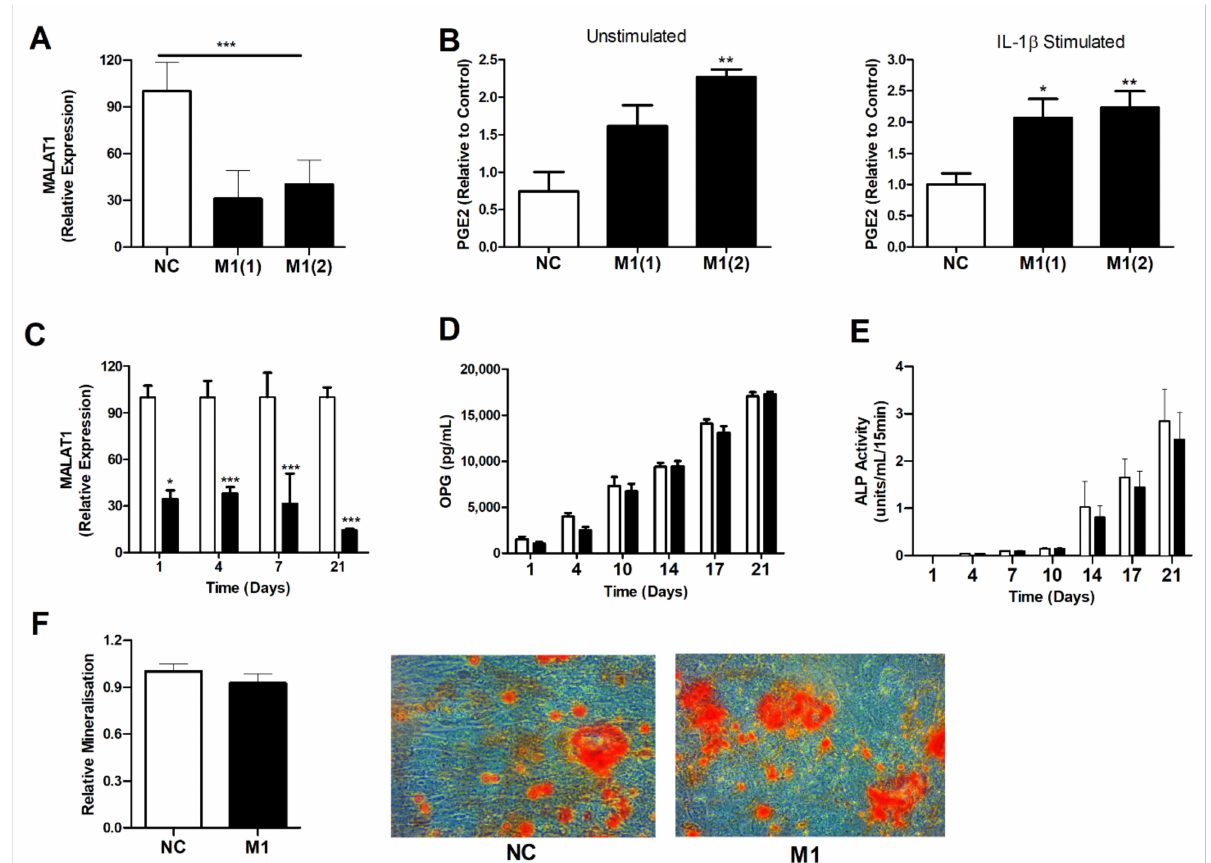
Figure 3. The effect of MALAT1 knockdown on the function of OA osteoblasts. ( A ) Knockdown of MALAT1 in OA osteoblasts ( n = 6) following 24 h transfection with LNAs targeting MALAT1 (M1(1) and M1(2)), compared to LNA control (NC). ( B ) Effect of MALAT1 knockdown on 24 h basal and IL-1 β mediated production of PGE2, as measured by ELISA. ** = p < 0.01 compared to non-stimulated control ( n = 6). ( C ) Sustained knockdown of MALAT1 expression in OA osteoblasts over 21 days following repeated transfection with a MALAT1 LNA or control LNA. * = p < 0.05, *** = p < 0.001 compared to non-stimulated control ( n = 6). ( D ) Production of OPG (pg/mL) over 21 days in control LNA and MALAT1 LNA transfected OA osteoblasts ( n = 6) as determined by ELISA. ( E ) Alkaline phosphatase (ALP) activity over 21 days in control LNA and MALAT1 LNA transfected OA osteoblast lysates ( n = 6). ( F ) Relative amount of osteoblast mineralisation following 21 days of transfection with control (NC) or MALAT1 (M1) LNA as determined quantification of absorbance at following alizarin red staining, and representative light microscope images ( × 40 magnification) showing alizarin red stained mineralised bone